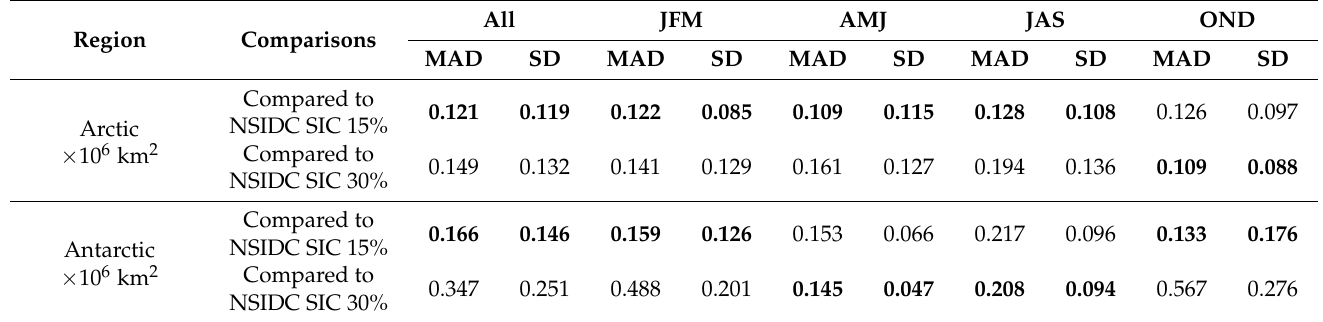
Table 5. Statistics of the comparisons between multisource scatterometer and NSIDC SIC 15% and 30% sea ice extents for different periods: All refers to all data; JFM is for the months January, February, and March; AMJ is for months April, May, and June; JAS is for months July, August, and